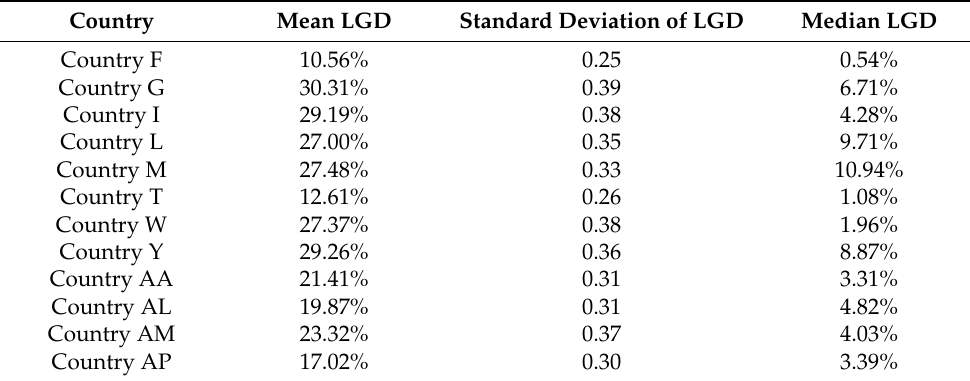
Table 13. Summary statistics of the LGD of 12 countries.